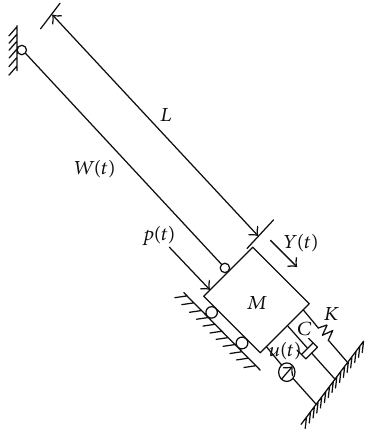
Figure 1: The mechanical model of cable and deck.